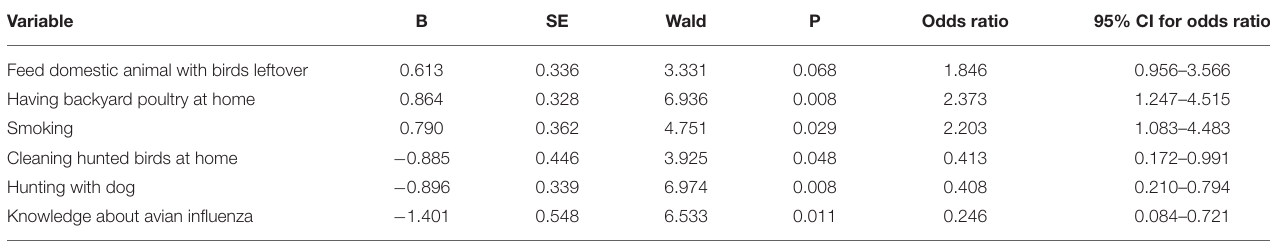
TABLE 4 | Maximum likelihood estimates of multivariate regression function of variables derived from individual analyses between Manager hunters and Pure hunters. Variable B SE Wald P Odds ratio 95% CI for odds ratio Feed domestic animal with birds